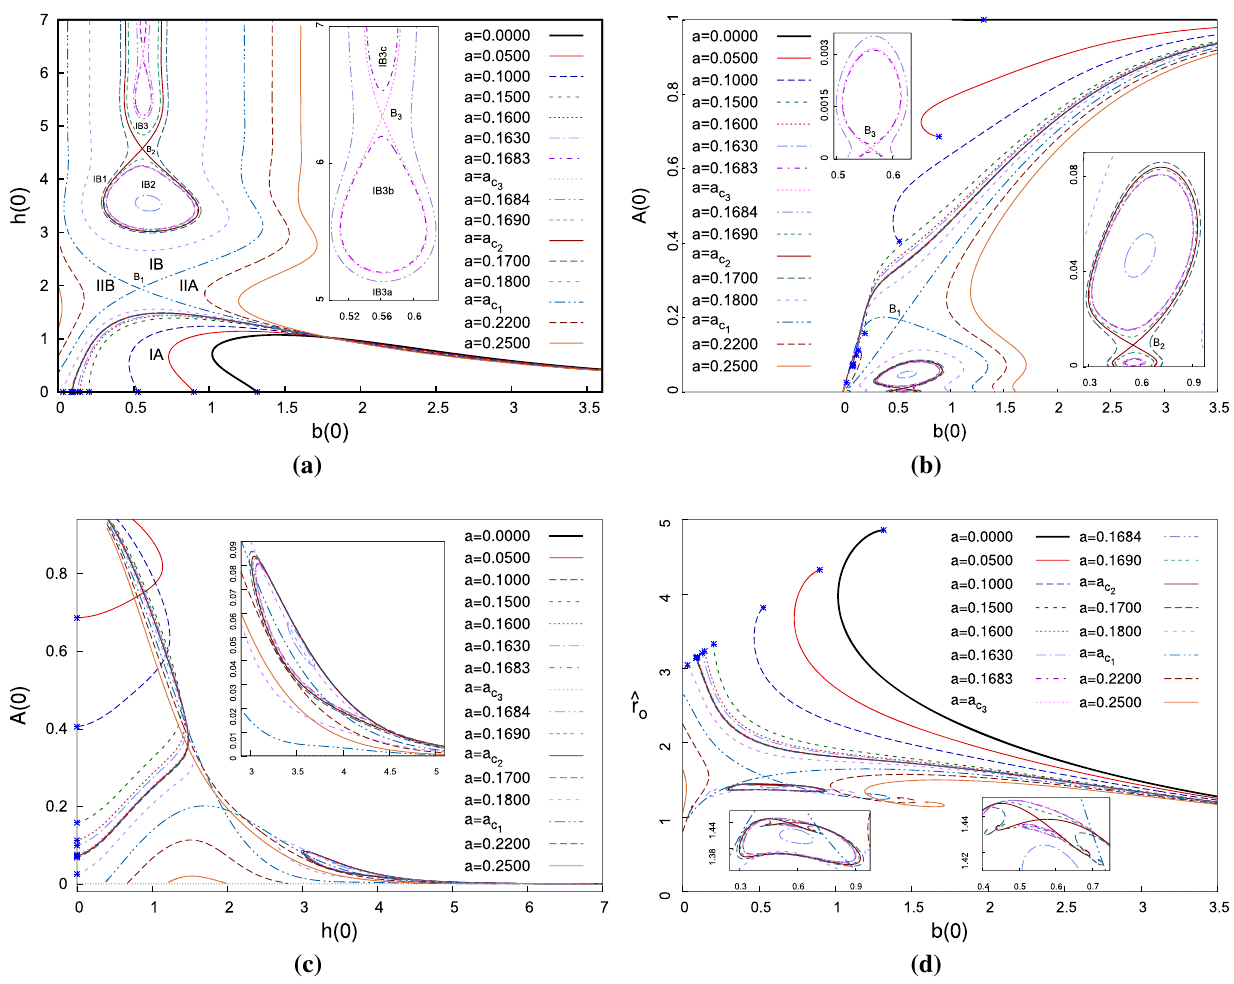
Fig. 1 a – c Depict the 2D phase diagrams, showing, respectively, h ( 0 ) versus b ( 0 ) , A ( 0 ) versus b ( 0 ) and A ( 0 ) versus h ( 0 ) (where h ( 0 ) , b ( 0 ) and A ( 0 ) denote the values of these fields at the centre of the star). d Depicts ˆ r o versus b ( 0 ) . The figures show different sets of a in the